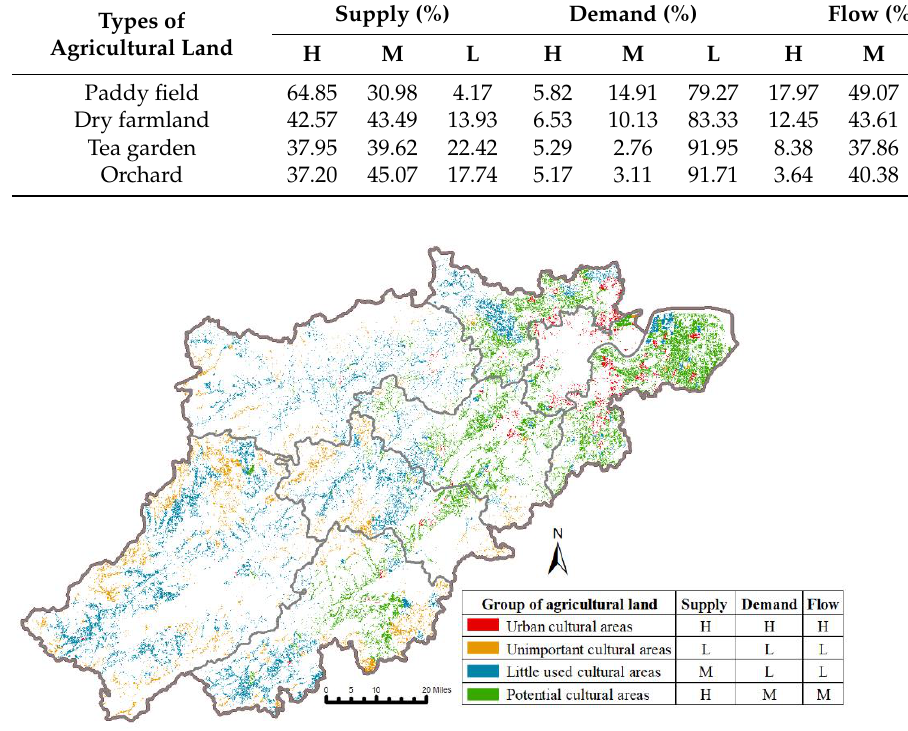
Figure 4. Groups of agricultural land with similar CES supply, demand, and flow values, produced by cluster analysis. by cluster